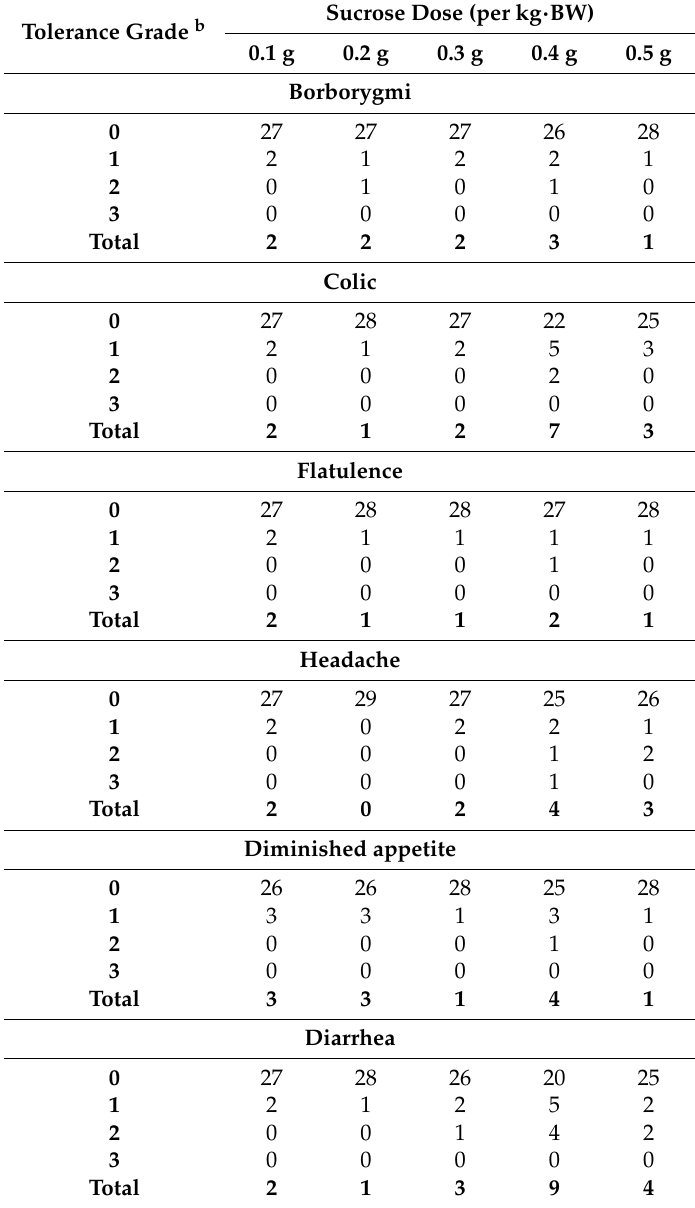
daily total intake of D-allulose as regular ingestion are shown in Table 8. The test results for the calculation of the maximum total daily intake of D-allulose are shown in Table 9. On the eighth day, when 1.0 g/kg · BW of D-allulose was administered, the subjects displayed severe levels of nausea (one subject), abdominal pain (one subject), headache (one subject), anorexia (one subject), and diarrhea (two subjects), as shown in Table 9. Thus, the maximum total daily intake of D-allulose was 0.9 g/kg · BW (57.80 ± 9.54 g), indicating that adults weighing 60 kg can consume a maximum of 54 g of D-allulose,